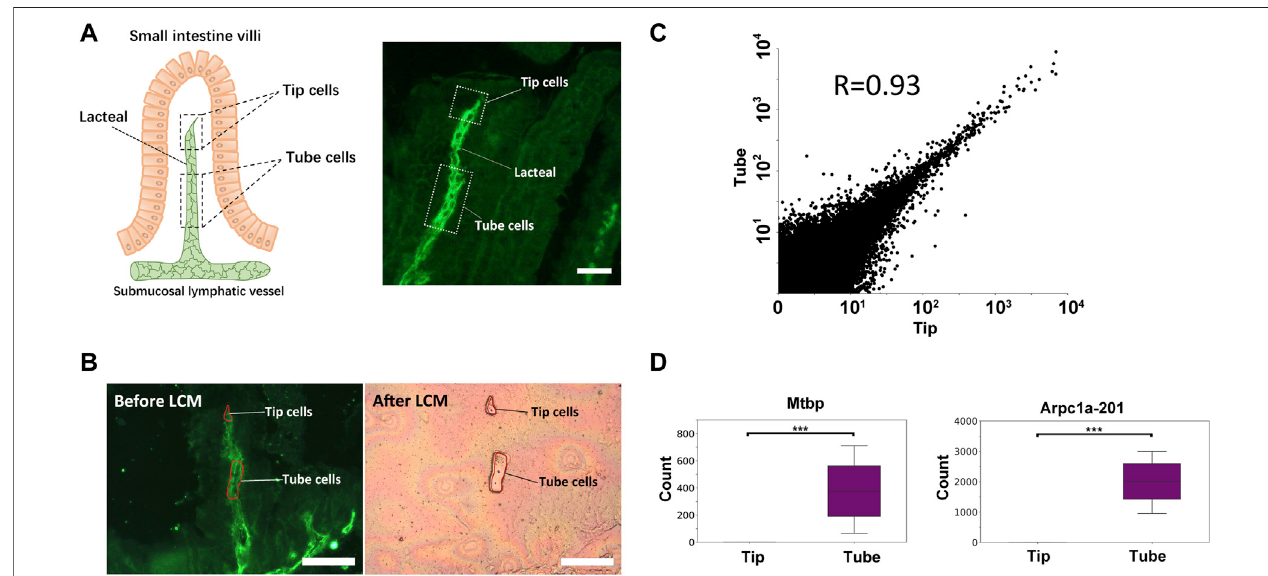
FIGURE 7 | Transcriptome differences between the tip and the tube of the mouse small intestine lacteal. (A) Illustration of the small intestine lacteal structure (left) and a typical IF image of the lacteal (right), labelled with an anti-Lyve1 antibody. Scale bar: 50 μ m. (B) Microdissection of the lacteal: tip cells and tube cells are collected separately with LCM. Each tip sample was pooled from up to 100 lacteals. Scale bar: 100 μ m. (C) Scatter plot of the expression levels of the tip and the tube with all replicatescombined.Thehighlyconsistentnatureofthetranscriptomeisexpectedsincethesearealllymphaticendothelialcells.Althoughboththetipandthetube areconsidered tohavethesamephenotype, signi fi cantexpression differences arestillidenti fi ed.Shown in (D) aretwogenesthatareonlyexpressed inthemainbodyof the tube: Mtbp and the Arpc1a - 201 isoform (***, p adj < 10 − 5 ).